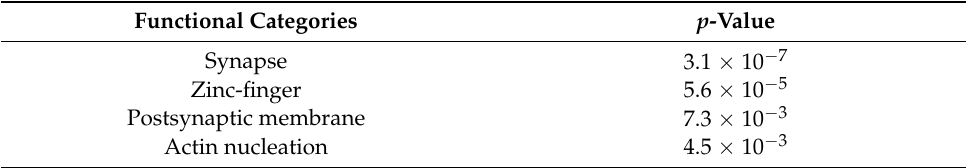
Table 4. Functional categories of genes differentially expressed in the hippocampus of GABA- administered mice.